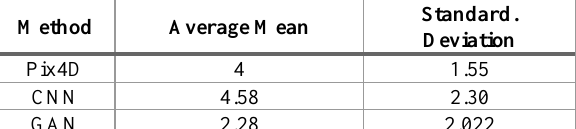
Figure 13. External quality assessment-Depth map Method